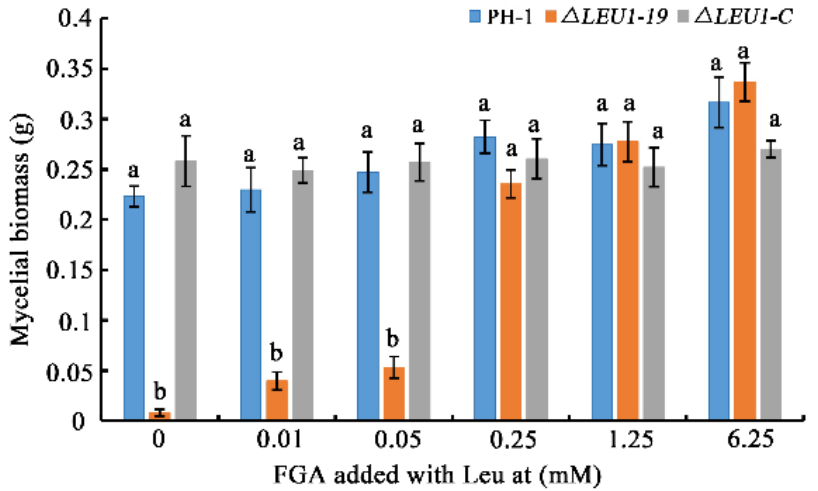
Figure 6. The mycelial biomass of wild-type, ∆ LEU1 , and ∆ LEU1 -C strains with different concen- trations of leucine. Different concentrations of leucine (final concentrations 0, 0.01, 0.05, 0.25, 1.25, and 6.25 mM) were added to fructose gelatin broth medium and the strains were cultured at 25 ◦ C, 180 rpm, for 6 days. Mycelium was collected from the medium, dried at 65 ◦ C and weighed after two days. Error bars represent the standard errors of the means. Different letters on the bars for each treatment indicate significant differences at p < 0.05 by Duncan’s multiple range te st.